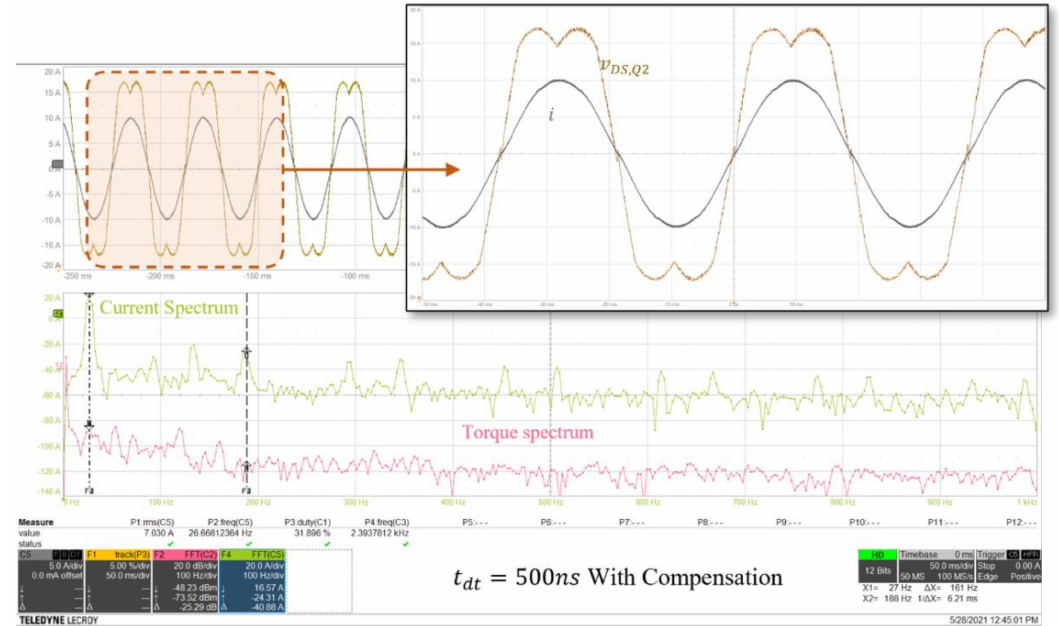
Figure 21. Motor current in the time domain and DFT of phase current and machine mechanical torque 50 ms/div. t dt = 500 ns and no compensation algorithm. C5: motor phase current i 0 = 5 A/div. F1: reconstructed inverter voltage v DSL = 5 V/div. F2: DFT of the mechanical torque 500 mV/Nm. F4: DFT of the inverter phase